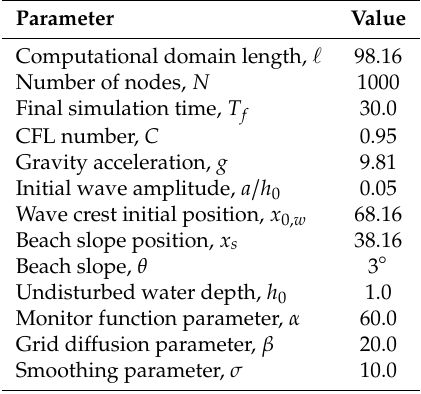
Table 7. The numerical parameters used in a solitary wave run-up simulation in nonlinear shallow water